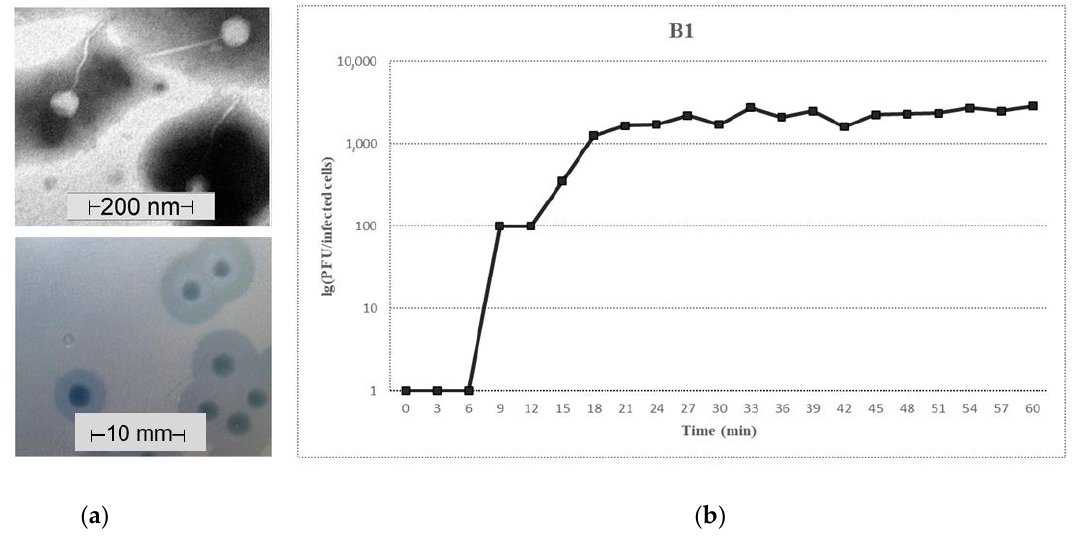
Figure 1. Characteristics of the B1 phage. ( a ) Electron micrograph of B1 phage stained with 1.5 w / v phospho-tungstic acid (top) and plaques on 52145 WT lawn (bottom). Scale bars represent 200 nm and 10 mm, respectively. Individual plaques were acquired by agar overlay method. ( b ) One-step growth curve of phage B1. The plaque-forming unit (PFU) per infected cell at different times are shown. Data are the mean of three independent experiments.